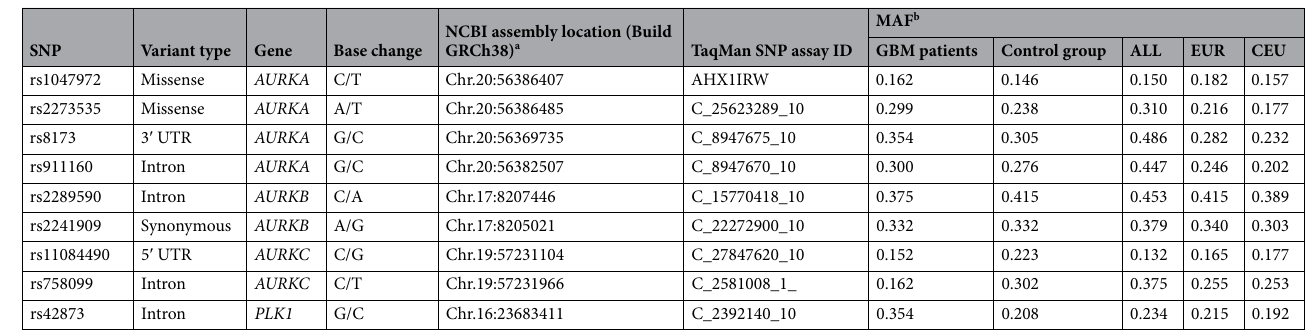
Table 2. Basic characteristics of the studied genetic variants. ALL all phase 3 individuals, CEU Utah residents with Northern and Western European ancestry, EUR European population, GBM glioblastoma multiforme, MAF minor allele frequency, SNP single nucleotide polymorphism, UTR untranslated region. a https:// www. lifet echno logies. com . b MAFs extracted from 1000 Genomes Project Phase